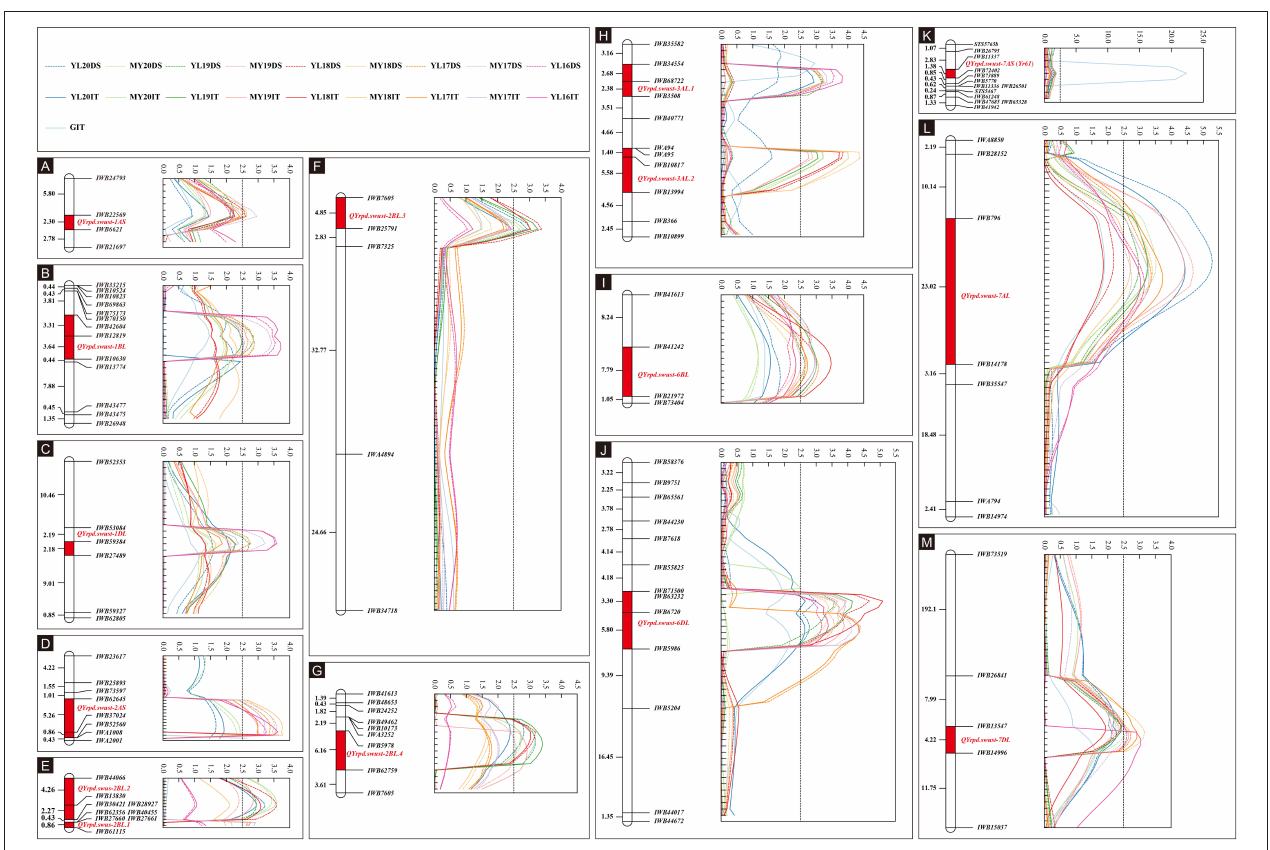
FIGURE 4 | Stripe rust resistance QTLs on the genetic map of chromosomes 1AS, 1BL, 2AS, 2BL, 3AL, 6BL, 6DL, 7AS, 7AL, and 7DL based on IT and DS data (A–M) . The y-axis is in centimorgan distance (cM), and all genetic distance values shown are in the same scale; the x-axis indicates the LOD value, and all LOD values of QTL showed are in same scale except in K. The dotted line with different colors represents LOD value calculated based on the DS data from nine different environments. The solid line with different colors represents the LOD value calculated based on IT data from 10 different environments including greenhouse. The red rectangle on the genetic map indicates the corresponding QTL